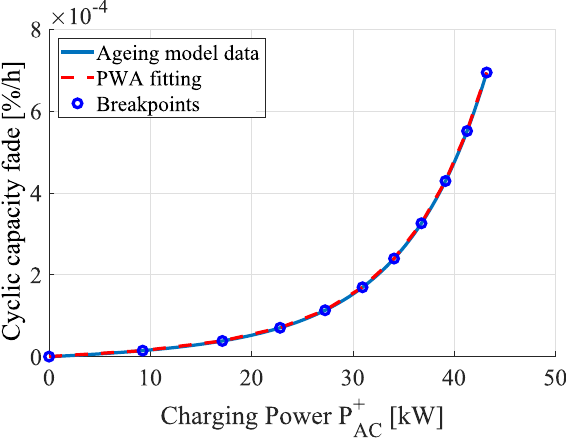
Figure A6. Piecewise affine (PWA) curve fitting for the semi-empirical cycle ageing curve (charging). A sample PWA function is given in the form of Equation (A1) and the actual function can be approximated by selecting the maximum value of the pieces, as in Equation (A2)